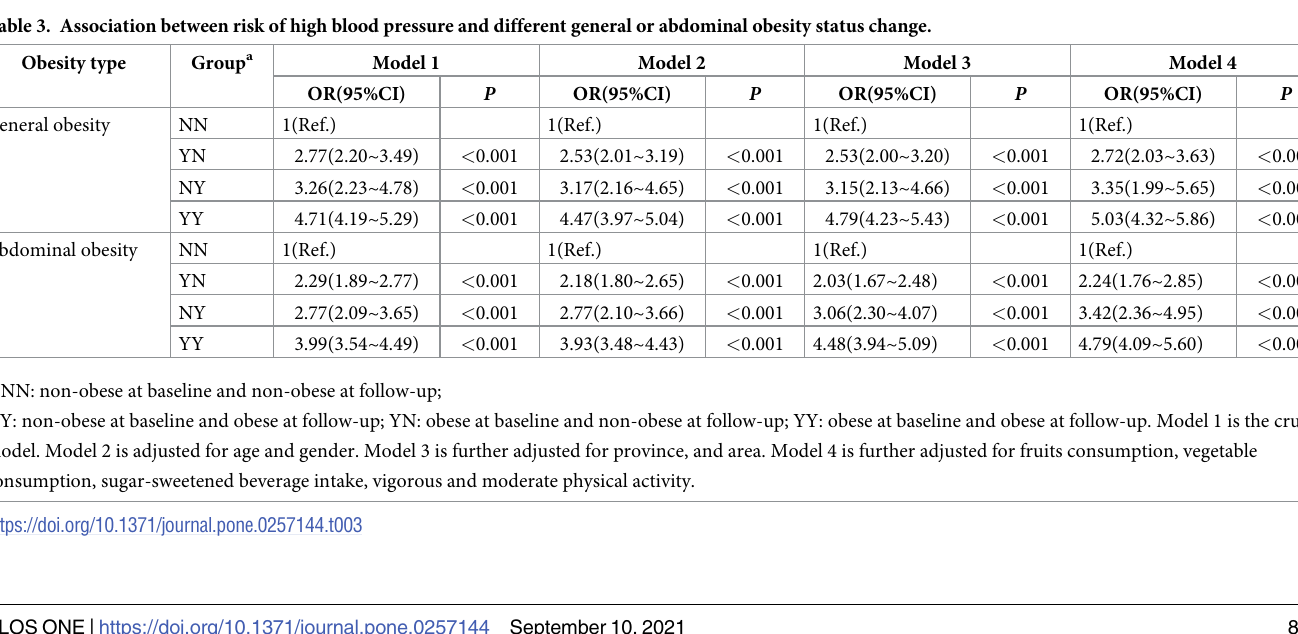
For children with GOB, when categorized as quintiles by the BMI change from baseline to fol-